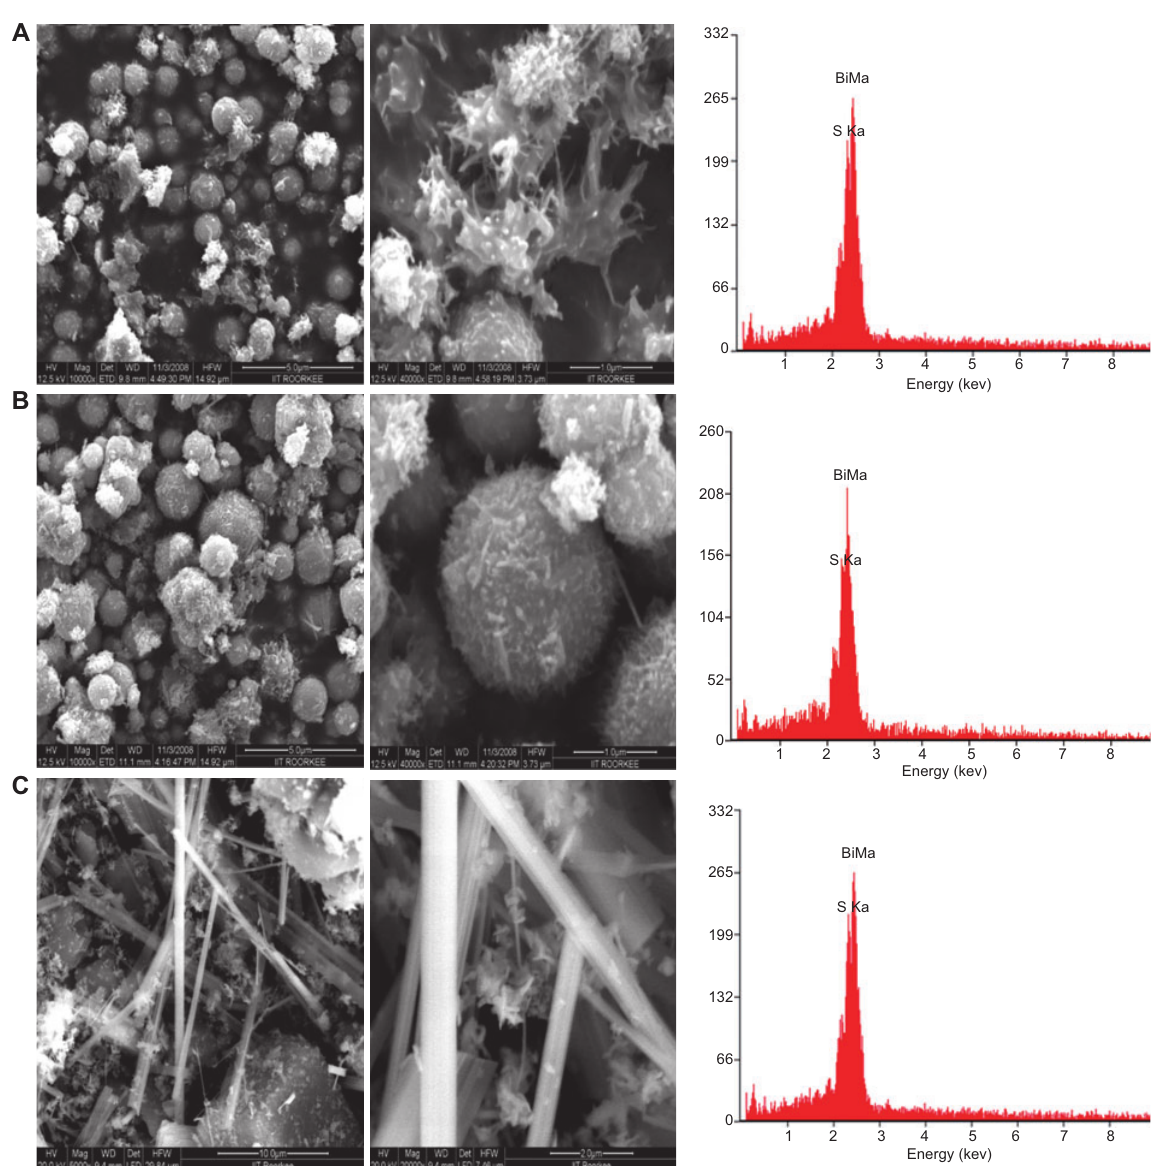
Figure 4 SEM and EDX images of Bi for ∼ 10 h.